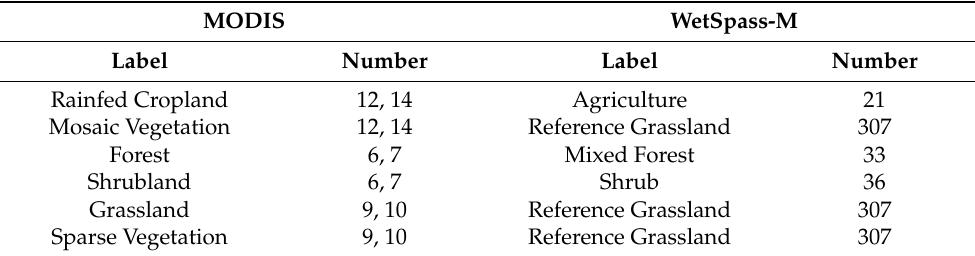
Table 1. Conversion table of MODIS land cover class values to WetSpass-M class values. MODIS WetSpass-M Label Number Label